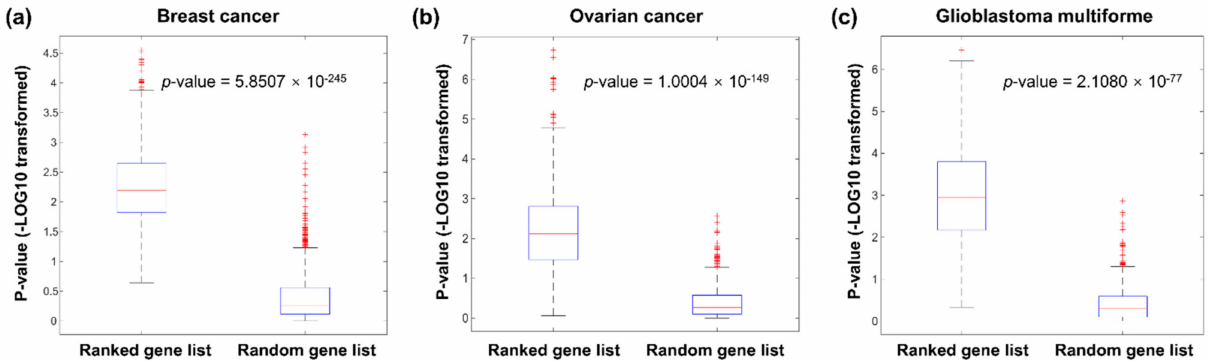
Figure 2. Analysis of the enrichment of known cancer genes among the ranked gene lists of all assessed BC ( a ), OV ( b ), and GBM ( c )